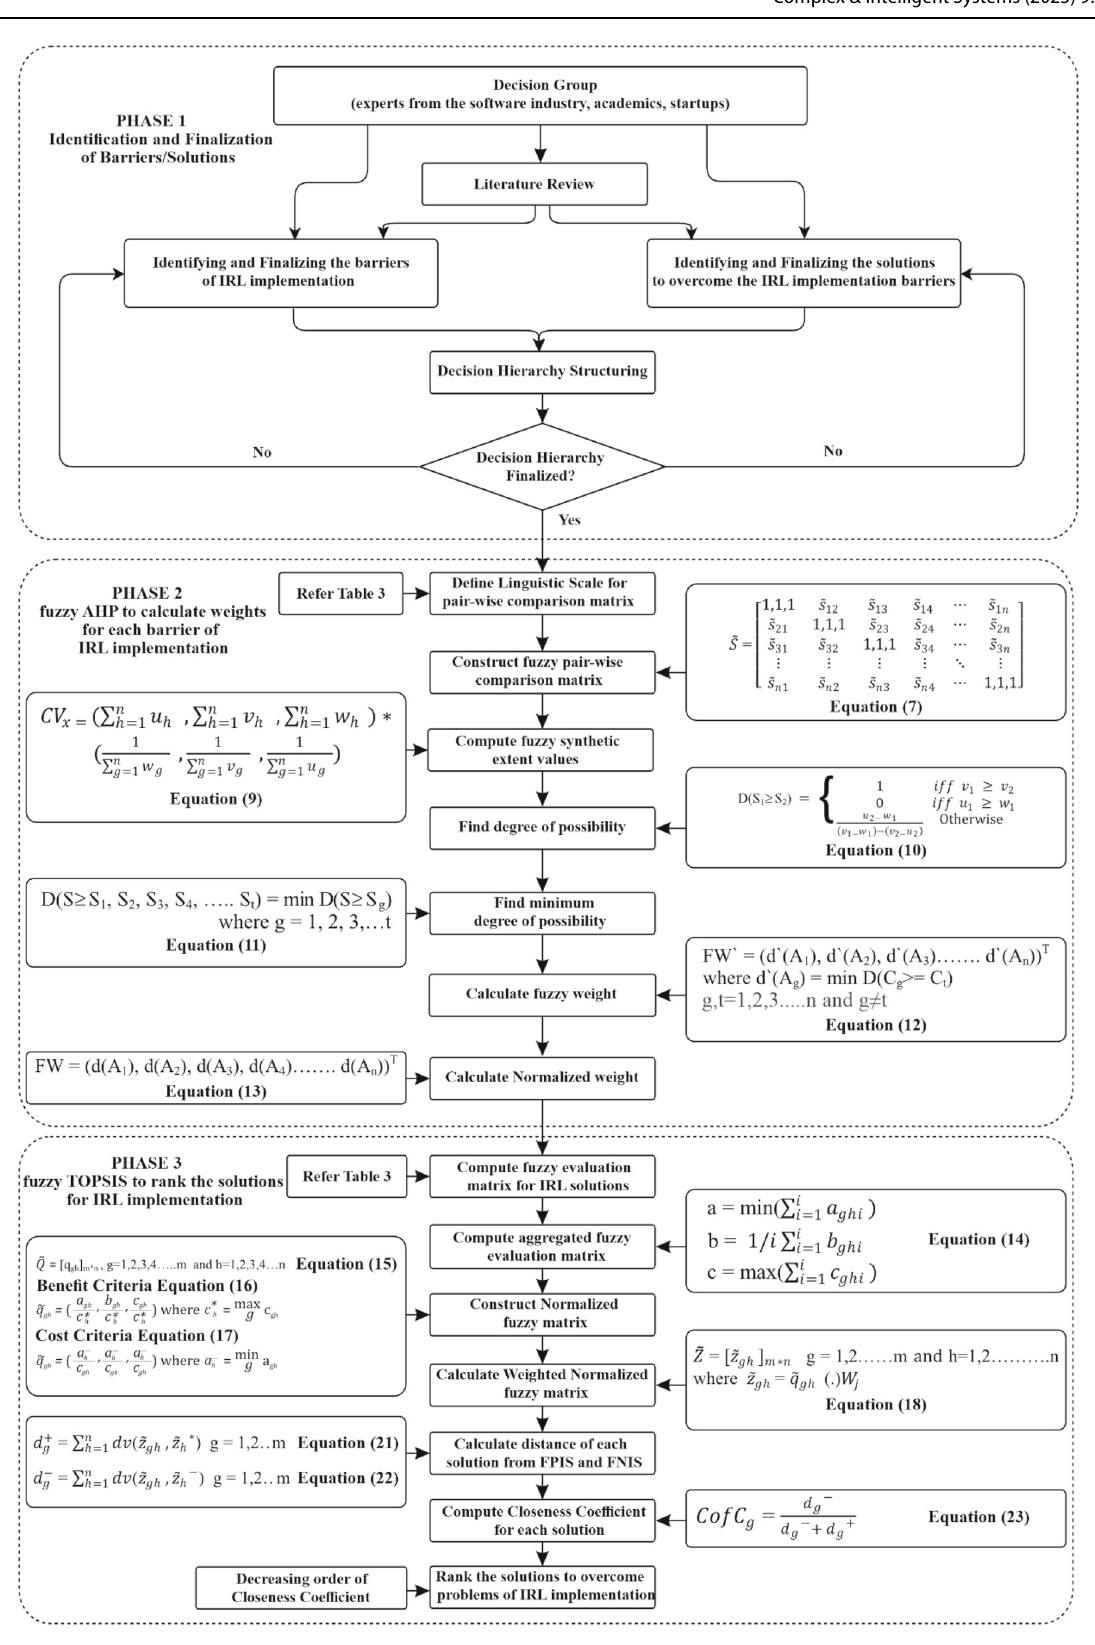
Fig. 1 Architectural schematization of the proposed